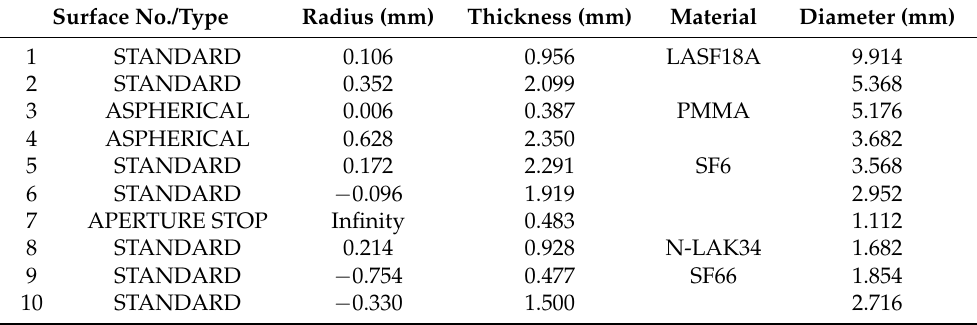
Table 3. Lens data of a miniaturized fisheye lens using a polymethyl methacrylate (PMMA) aspherical lens. Surface